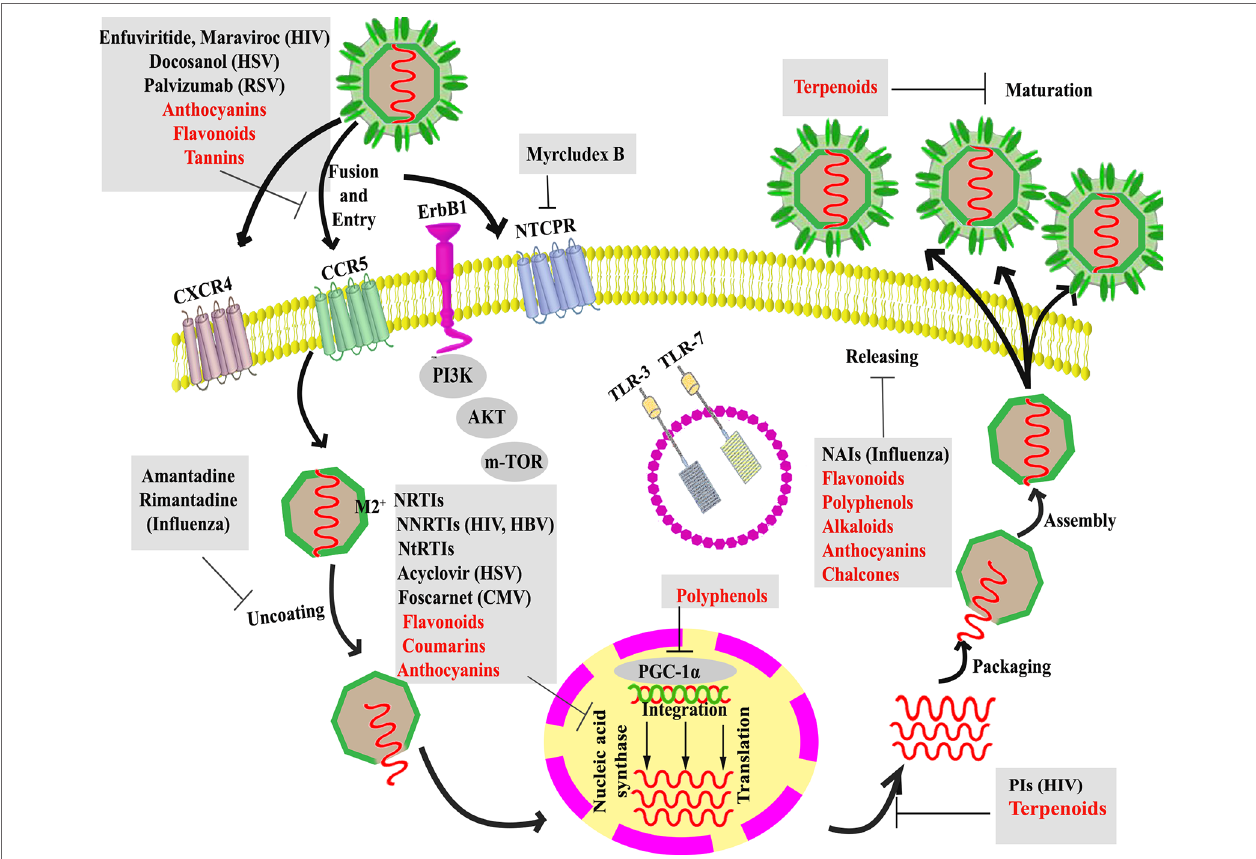
FIGURE 1 | Targeting host proteins and several steps of the viral life cycle by current therapeutic and alternative natural products (in red). HIV, human immunodeficiency viruses; RSV, respiratory syncytial virus; HBV, hepatitis B virus; HSV-1/2, herpes simplex virus-1/2, NtRTIs, nucleotide reverse transcriptase inhibitors; NRTIs, nucleoside reverse transcriptase inhibitors; and NNRTIs, non-nucleoside reverse transcriptase inhibitors; NAIs, neuraminidase inhibitors; PGC-1 α , peroxisome proliferator-activated receptor gamma coactivator